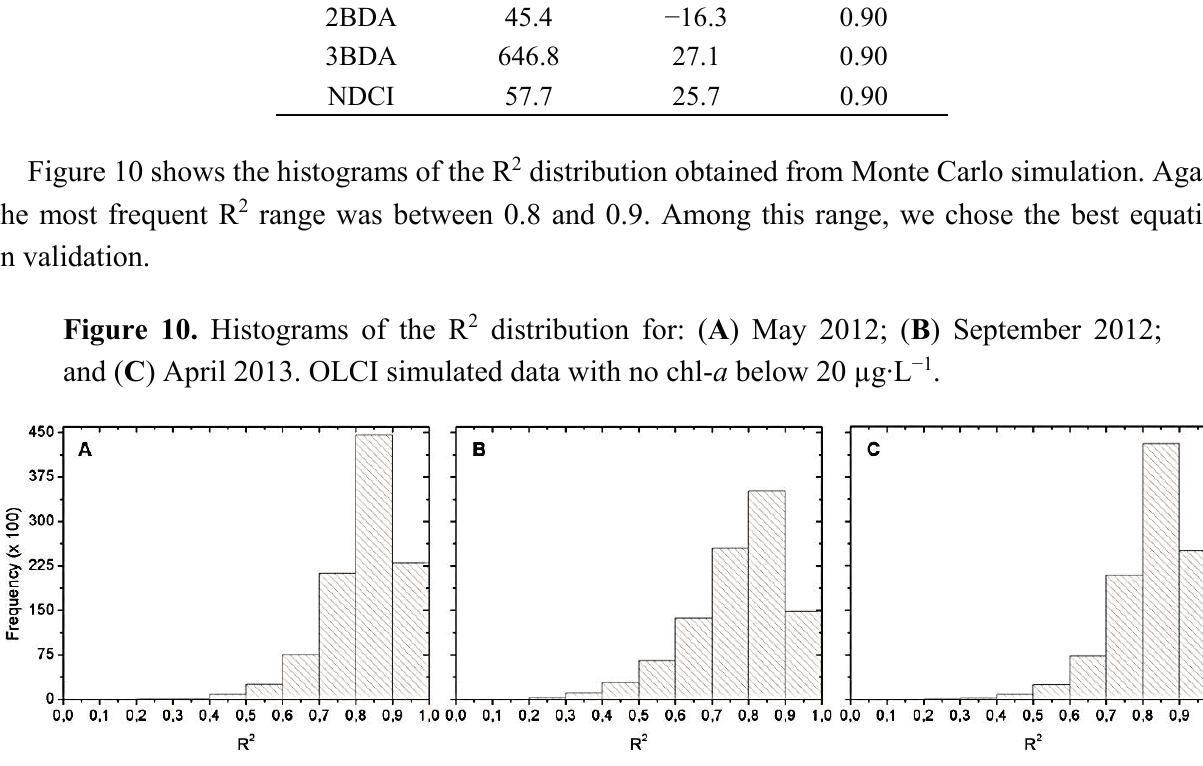
Table 8. Coefficients derived from model calibrations applied to OLCI simulated bands. Slope